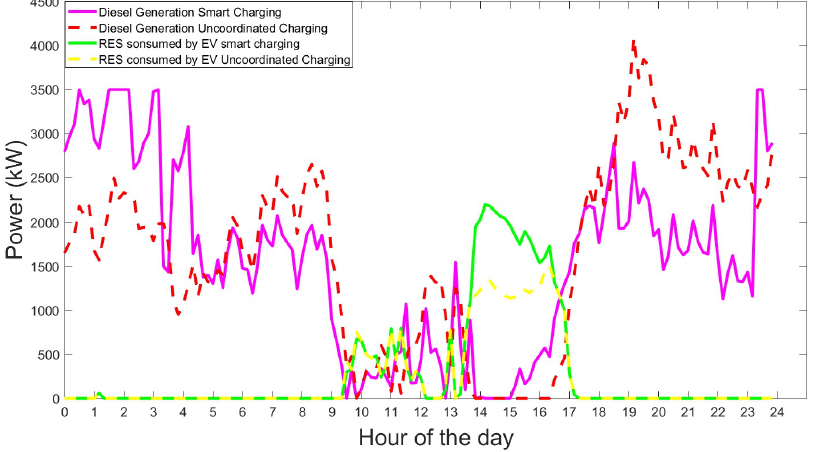
Figure 7. Diesel generation and RES power excess consumed by EVs for Scenario 1.